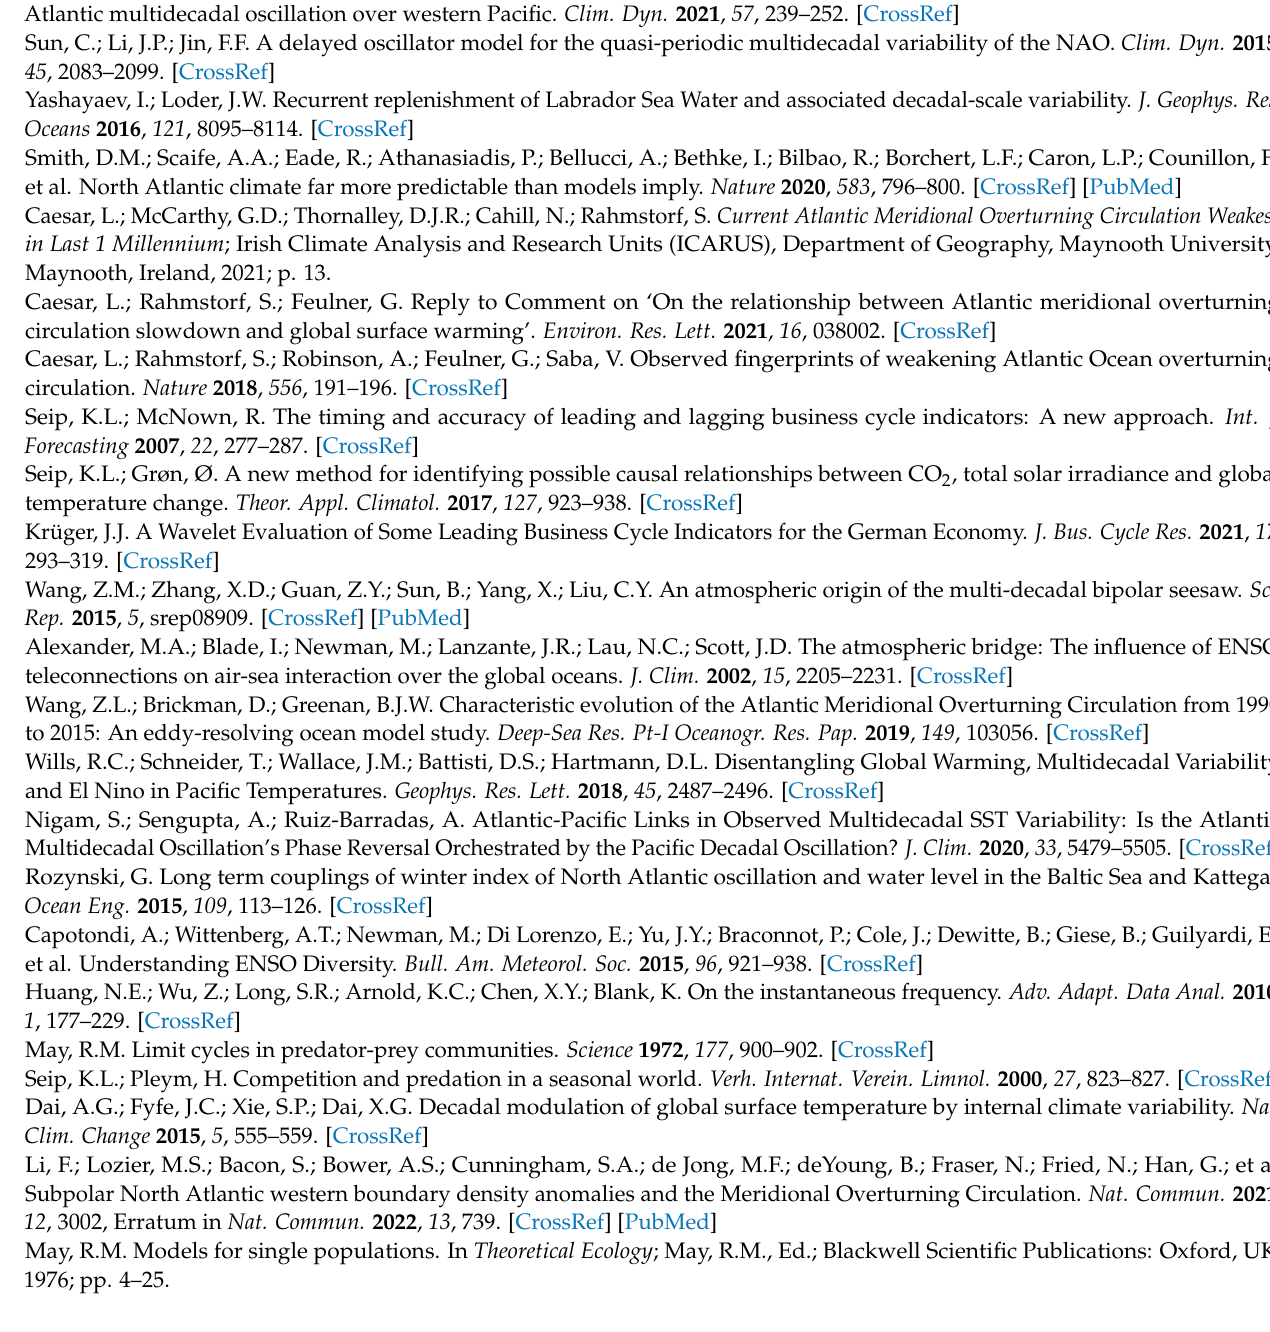
LOESS(0.3)-smoothed. The zigzag curve indicates the length of years found by the cumulative angle method. ( b ) LL relations between AMOC original and AMOC shifted 6 years forward, LL(AMOC, AMOC+6). The black bars show Ang(3); that is, LL relation over three consecutive observations in the paired time series. The grey bars show LL(9); that is, the relation between positive and negative angles over 9 consecutive observations. ( c ) Phase plot for the pairs AMOC and AMOC+6. Note that most rotations are counterclockwise (positive, +) showing that AMOC leads AMOC +6. ( d ) Phase shifts calculated relative to moving cycle period and with average cycle period. Average